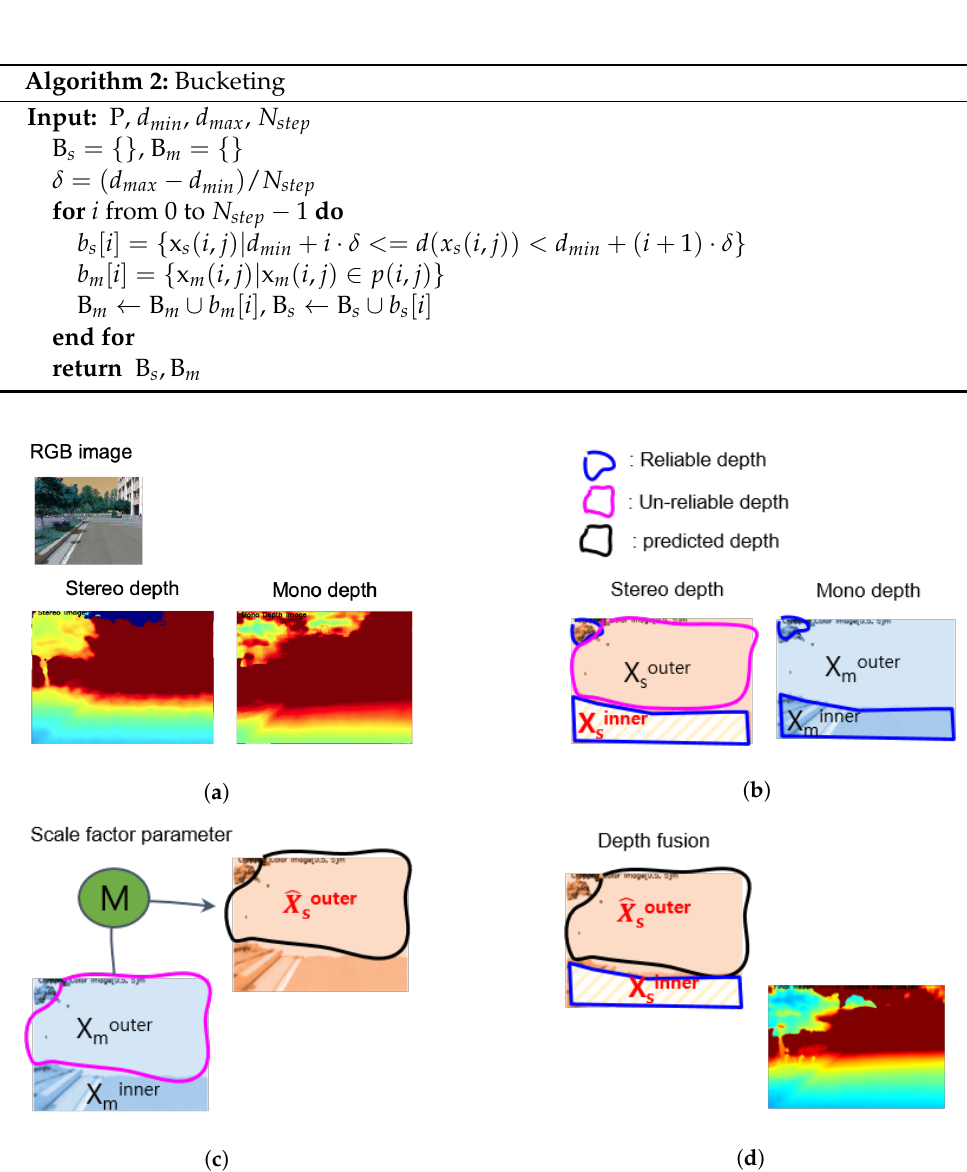
Figure 5. Detailed pipeline of the sensing range extension method. ( a ) RGB, Stereo and mono depths, ( b ) stereo-mono depth pair sampling, ( c ) outer stereo prediction using scale factor parameter model M, and ( d ) depth